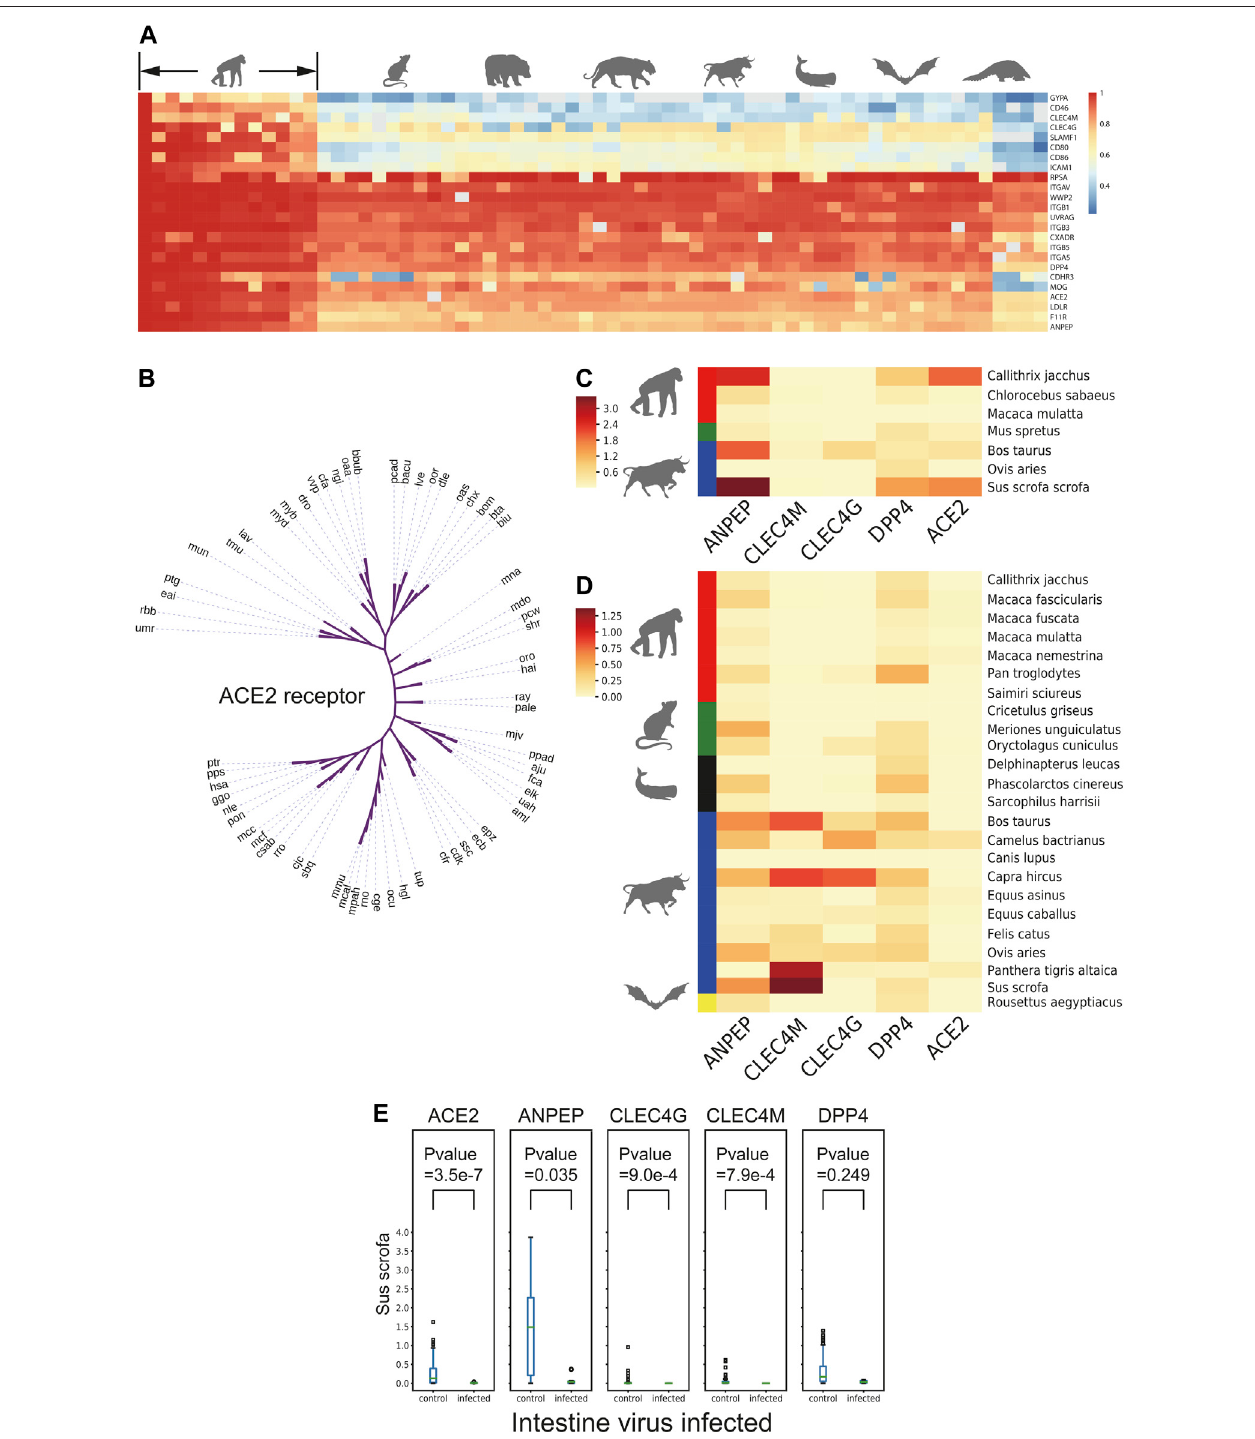
FIGURE3| Receptorconservationandexpressionlevelanalysis. (A) Heatmapofsequencesimilarityof24respiratoryreceptorsacross65species. (B) Cladogram of ACE2 across 65 species. (C) and (D) Heatmap of natural logarithm of mean expression of fi ve viral receptor genes expression in intestine and lung cross-species. (E) Box plot of natural logarithm of fi ve receptor genes expression level between PEDV infected and non-infected group in intestine of Sus scrofa . The number in brackets means infected/non-infected sample size.